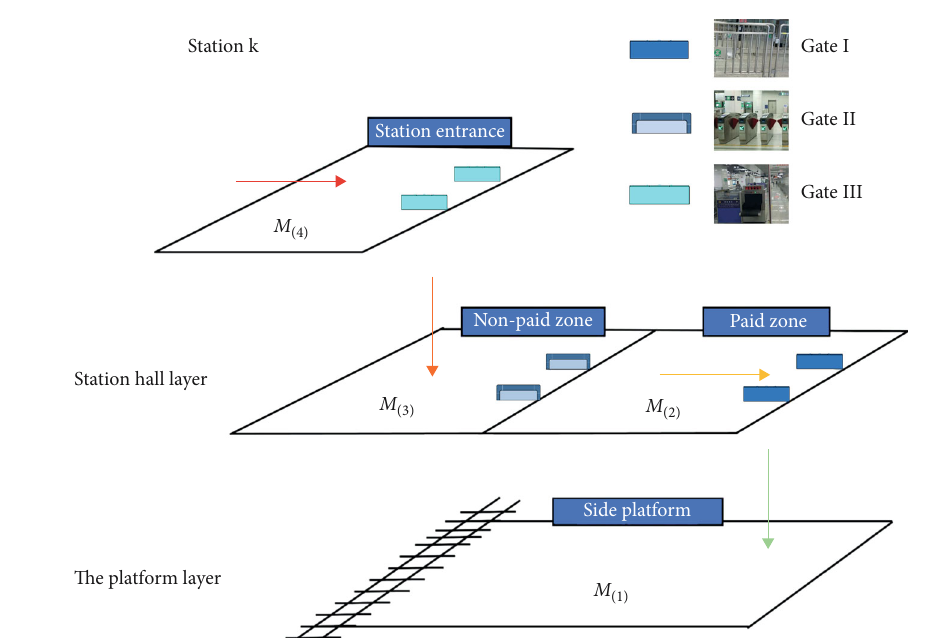
Figure 2: Illustration of the passenger fl ow control process at a single